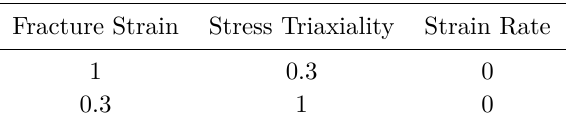
Table 1. Material behavior assigned in Abaqus (Elastic Isotropic).